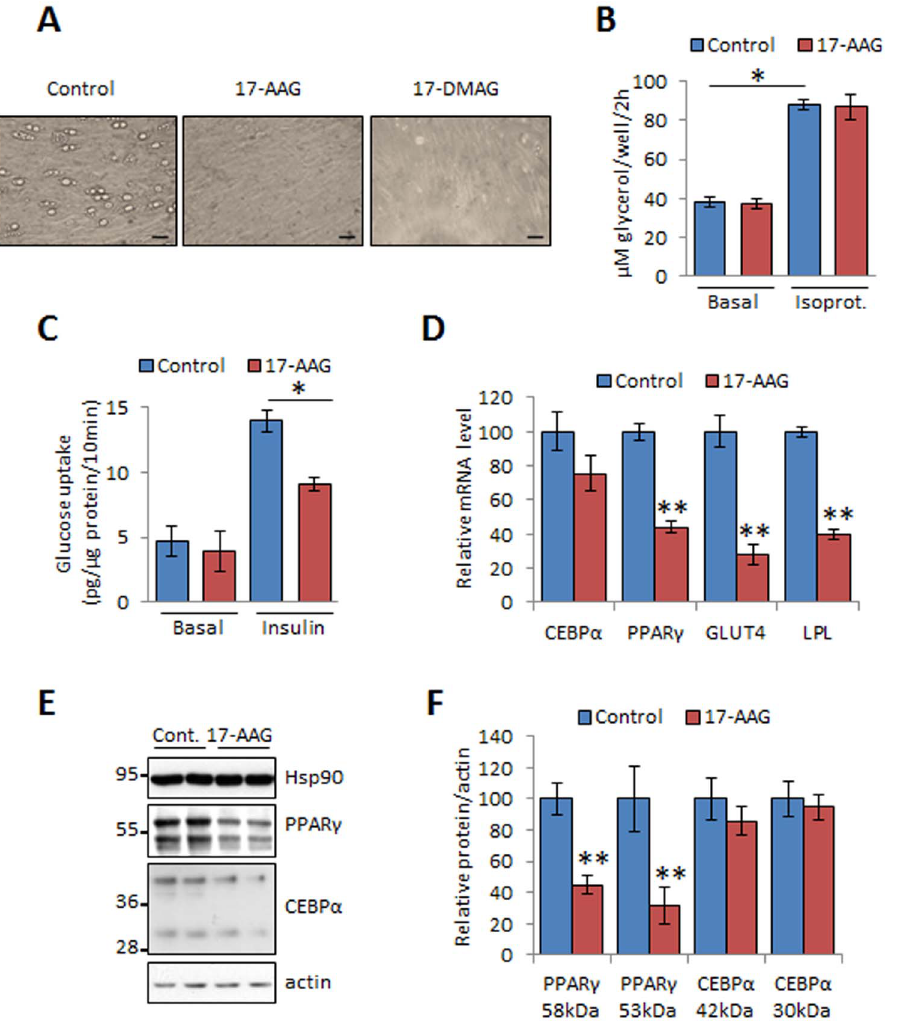
Figure 2. Hsp90 inhibition decreases the adipogenic transcriptional program without any effect on cytotoxicity. (A) Primary preadipocytes derived from white adipose tissue (WAT) of mouse gonadal fat were cultured for 10 days with 17-AAG (300 nM) or DMSO (Control) and visualized by microscopy 40X (scale bar: 50 m m). (B) Mature 3T3-L1 were cultured for 2 days with or without 17-AAG (100 nM) and tested for an additional 2 h for lipolysis in response to 1 m M of isoproterenol. (C) 3T3-L1 cells were induced to differentiation in presence of 17-AAG for 2 days then tested for [ 3 H]-Deoxy-D-glucose uptake for 10 min. (D) 3T3-L1 preadipocytes were induced to differentiation in presence or absence of 17-AAG for 10 days. The abundance of CEBP a , PPAR c , LPL and Glut4 mRNA in 3T3-L1 cells was measured by quantitative RT-PCR. Given are means relative to GAPDH of 3 experiments performed in duplicates 6 SEM, **p , 0.01. (E) Cell lysates were analyzed by immunoblotting using antibodies against Hsp90, PPAR c , CEBP a and actin as a loading control. (F) The protein expression levels were quantified and values are given as mean 6 SEM (n=6), **p ,